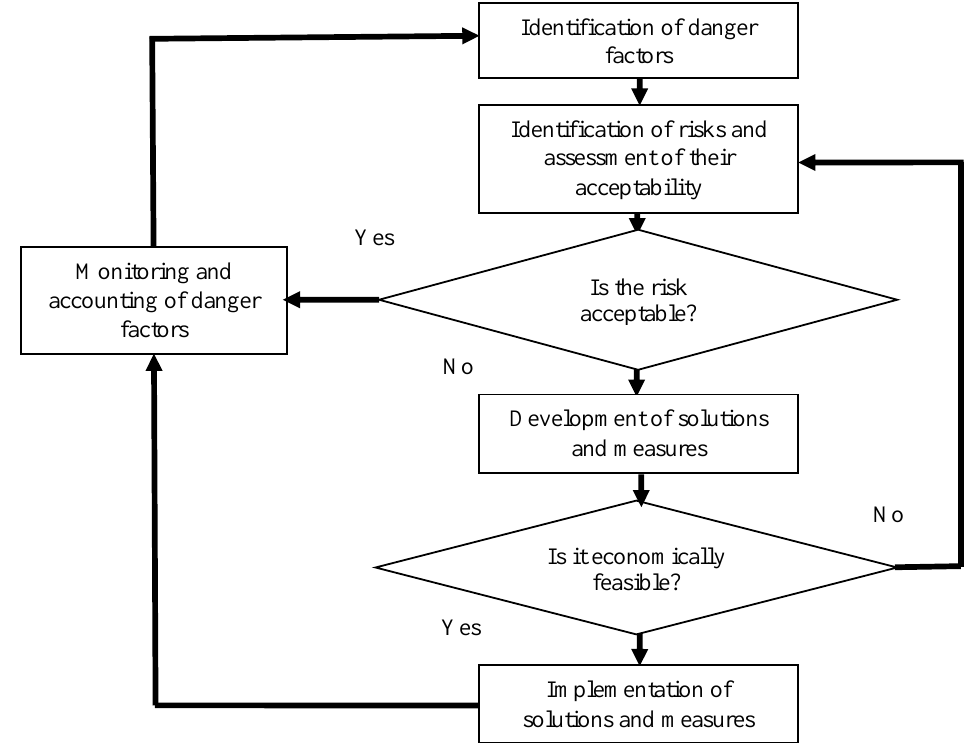
Figure 2. Risk management